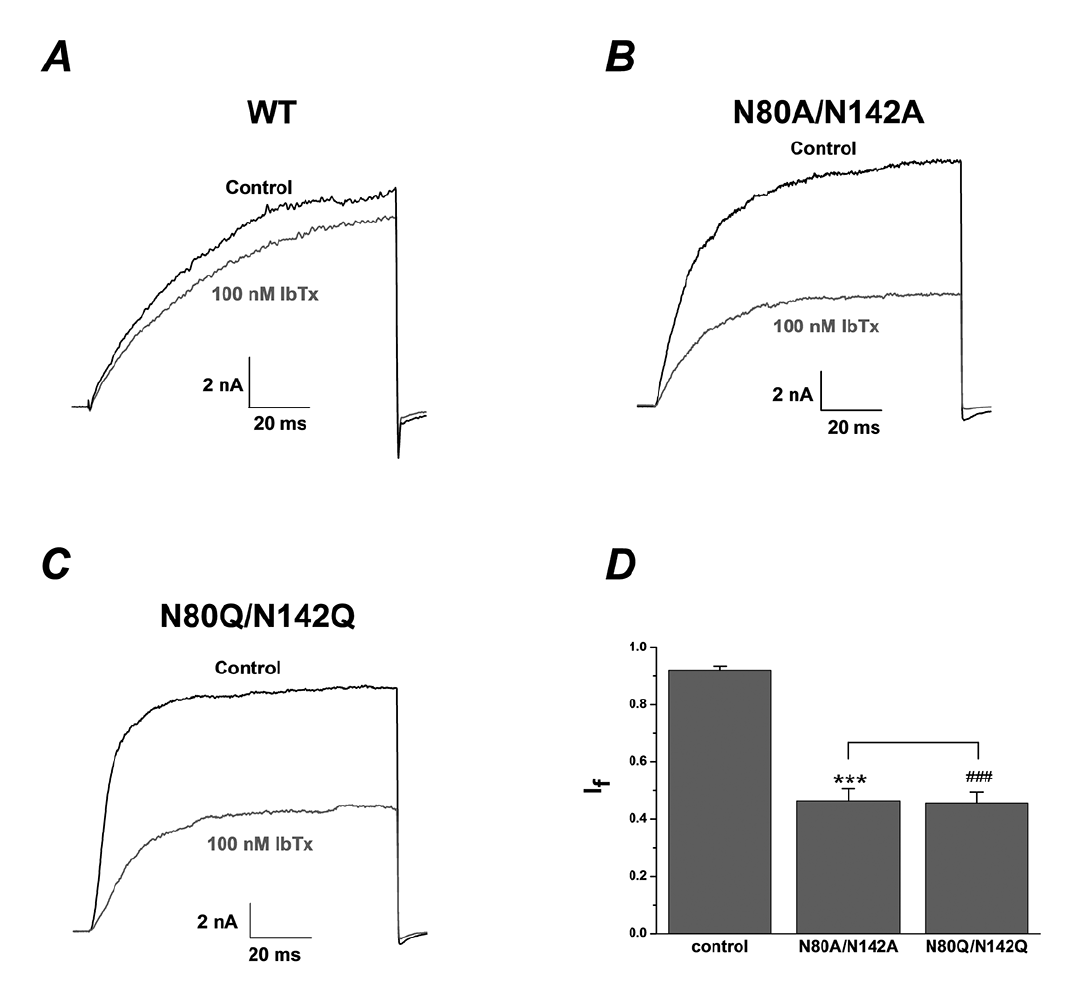
Figure 2. The inhibition effect of iberiotoxin on BK channels (a+ β 1) could be enhanced after deglycosylation of β 1 subunit. (A) Representative whole cell current traces from HEK 293T cells expressing wild-type BK channels (a+ β 1) before and after the application of IbTx 100 nM. The holding voltage was -80 mV and the currents were elicited by a pulse of +100 mV in the presence of 300 nM free Ca 2+ in the pipette solution. (B) Representative whole cell current traces from HEK 293T cells expressing mutant BK channels N80A/N142A before and after the application of IbTx 100 nM. (C) Representative whole cell current traces from HEK 293T cells expressing mutant BK channels N80Q/N142Q before and after the application of IbTx 100 nM. (D) Statistical analysis of pharmacological modulation of wild-type BK channels (a+ β 1) (n = 7) and N80A/N142A (n = 7, ***p < 0.001) or wild-type BK channels (a+ β 1) (n = 7) and N80Q/N142Q (n = 6, ### p < 0.001) by IbTx 100 nM. The inhibition ratios of IbTx on the currents of N80A/N142A and N80Q/N142Q were not significantly different (p >